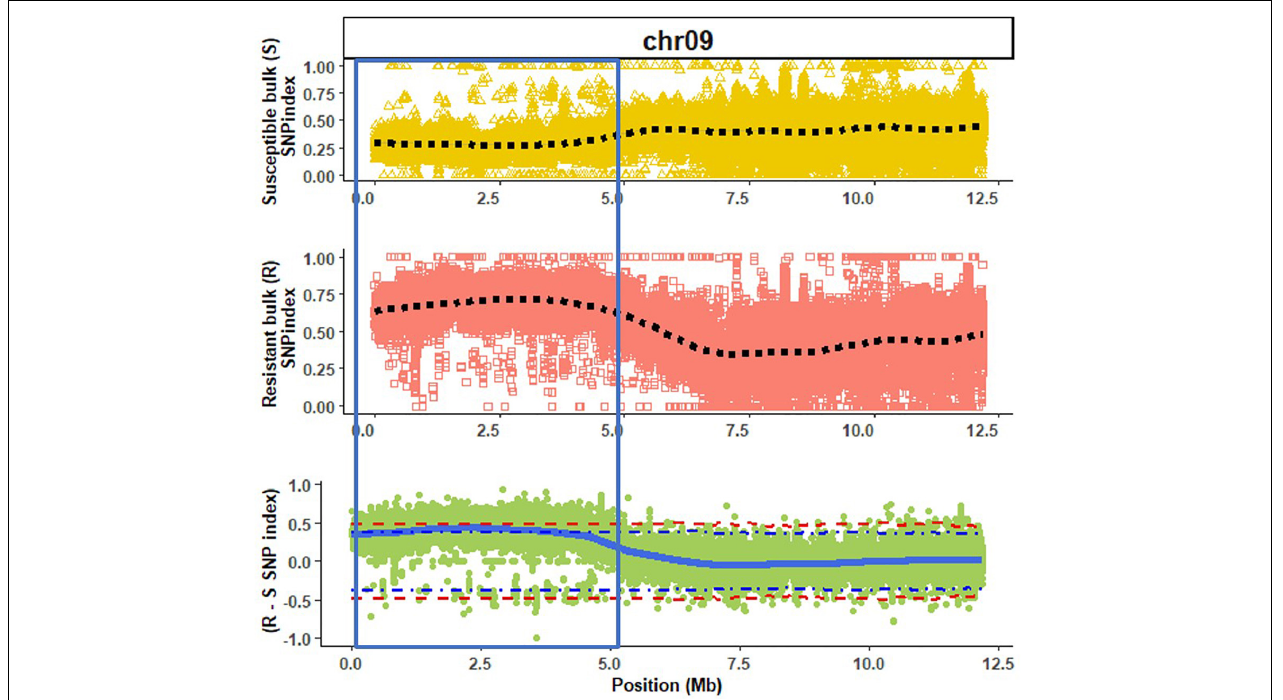
FIGURE 1 | A QTL ( QtlPRSV-C09; section within blue bar) associated with Papaya ringspot virus W resistance in Nigerian Local ( Cucurbita moschata ) on chromosome 9 (chr09) using Butterbush as the consensus reference genome. The dotted lines (black) represent the smoothed conditional mean for the SNP indexes of susceptible (S) and resistant (R) bulks. The solid blue line represents the tricube (cid:49) SNP index (R SNP index—S SNP index). The blue and red dotted lines in the (cid:49) SNP index plot are the 95 and 99% confidence intervals, respectively.